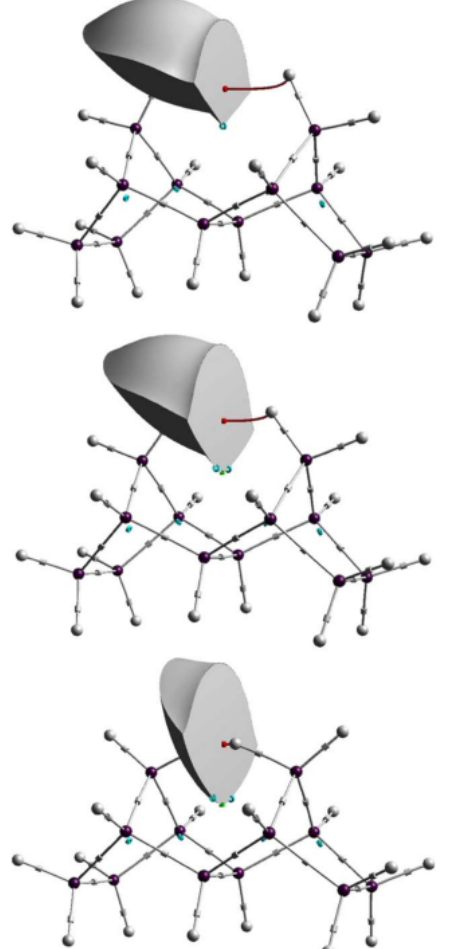
Figure 6. Atomic volume of one of the congested hydrogen atoms in tetra- cyclododecane at a H...H distance of 2.4 Å ( top ), the equilibrium distance of 1.831 Å ( middle ), and 0.5 Å ( bottom ). Figure taken from reference